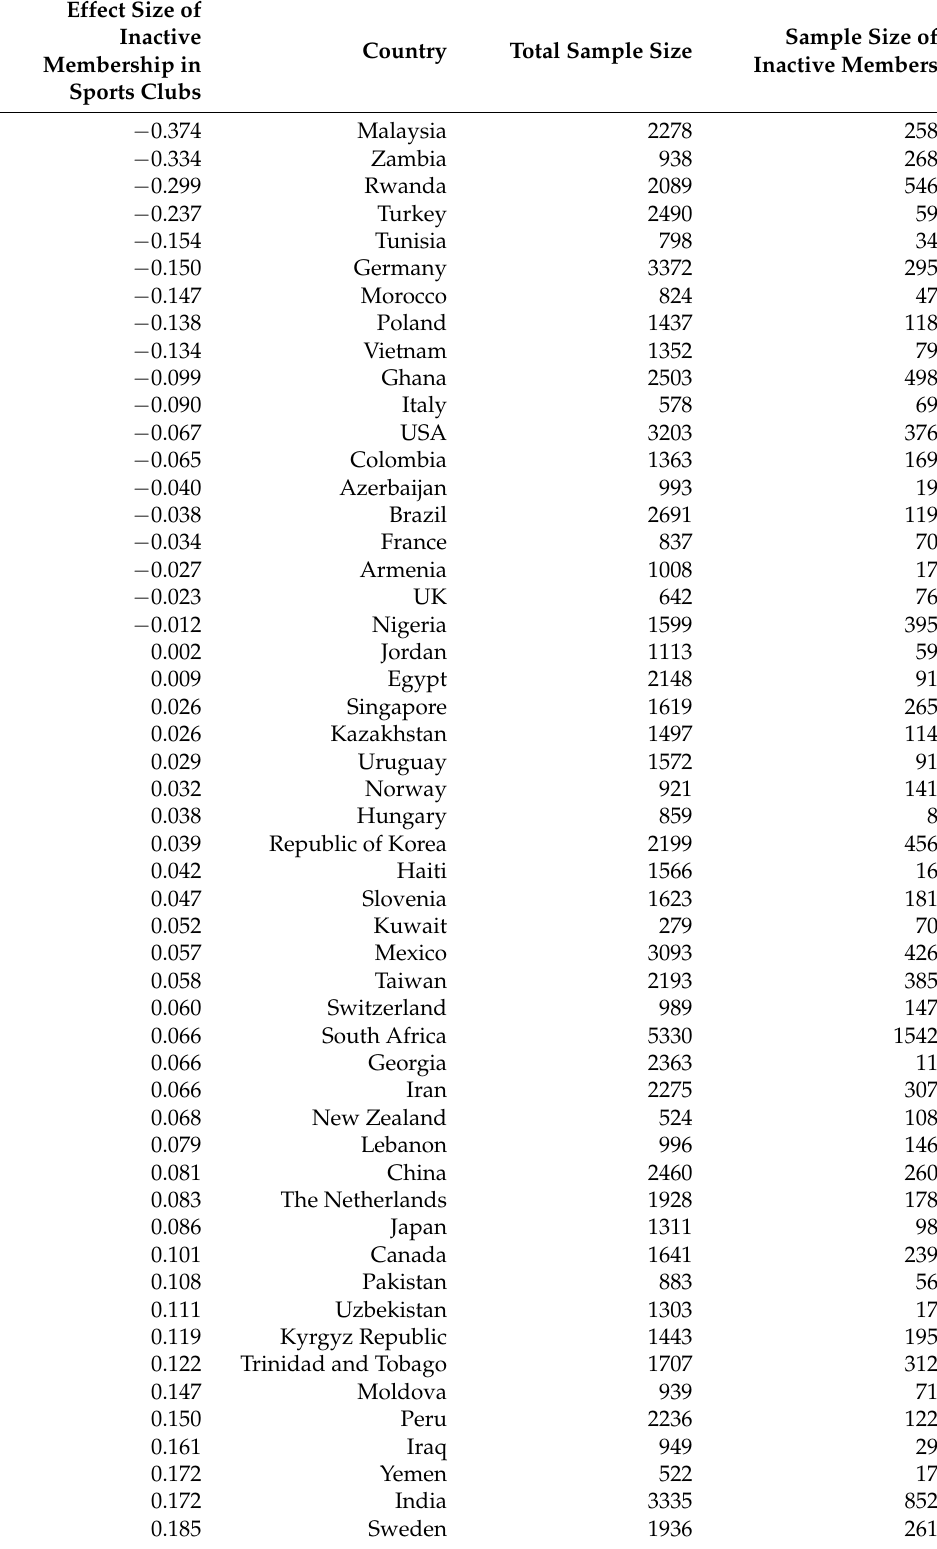
Table A3. List of country-specific effects for inactive membership in sports clubs on sexist gender ideologies for the group of men. Source: WVS-EVS